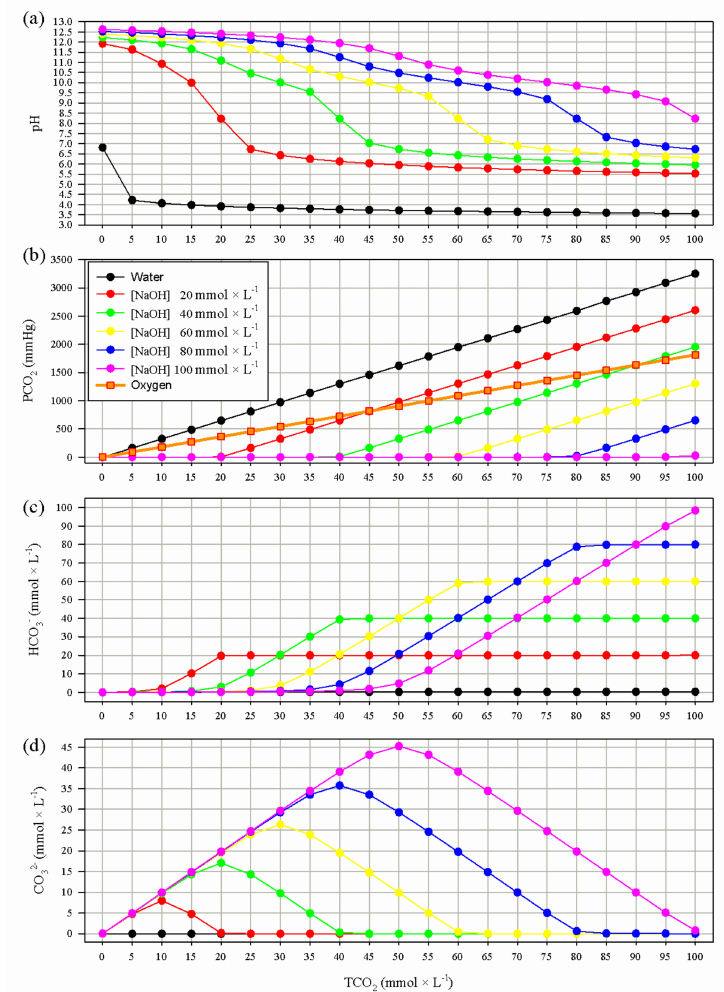
Figure 2. Simulated effects of increasing TCO 2 from 0 to 100 by 5 mmol × L − 1 in a closed system with aqueous NaOH at varying concentrations (from 0 (water) to 100 by 20 mmol × L − 1 ). Panel ( a ) represents pH; panel ( b ) represents PCO 2 , the orange line with red squares represents PCO 2 values of one closed liter of oxygen/gas containing increasing TCO 2 ; panel ( c ) represents HCO 3 − ; panel ( d ) represents CO 32 − . Abbreviations: PCO 2 , partial pressure of carbon dioxide; HCO 3 − , bicarbonate; CO 32 − , carbonate; TCO 2 , total CO 2